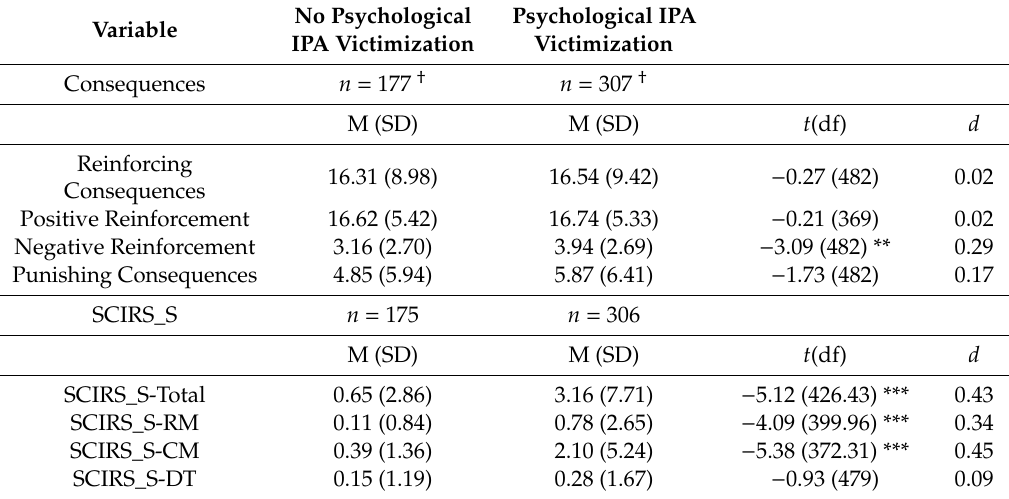
Table 3. Di ff erences in Sexting Consequences and Sexual Coercion Based on Psychological IPA Victimization History.